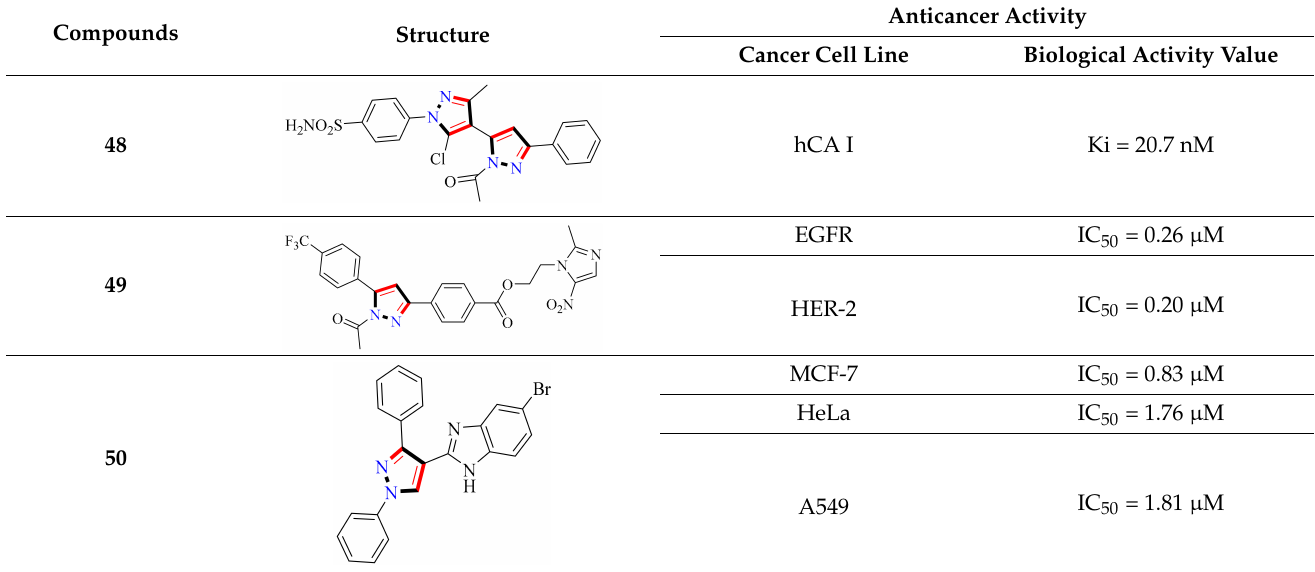
Table 5. Representative compound structures 48 to 64 and their anticancer